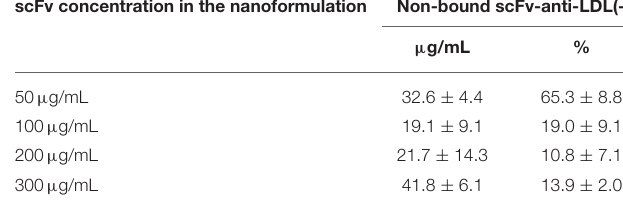
TABLE 1 | Quantification of non-bound scFv-anti-LDL(-) in the ultrafiltrate of scFv-anti-LDL(-)-MCMN-Zn nanoformulation containing different concentrations of